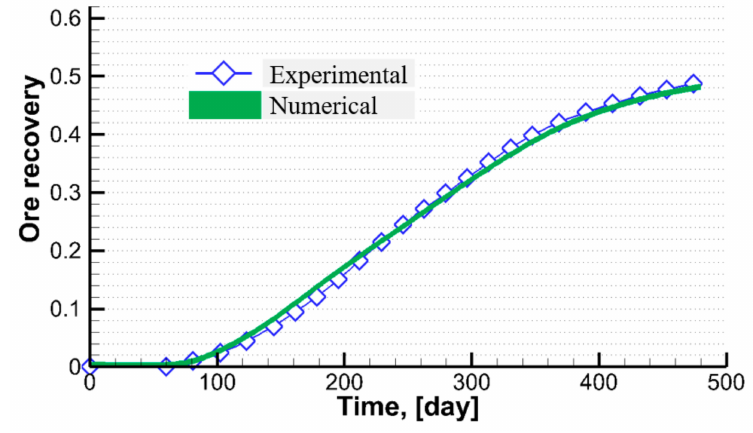
Figure 17. Simulated total recovery compared to experimental one vs. time. Table 12. Experimental data shift from simulated uranium concentration (see Figures 14 and